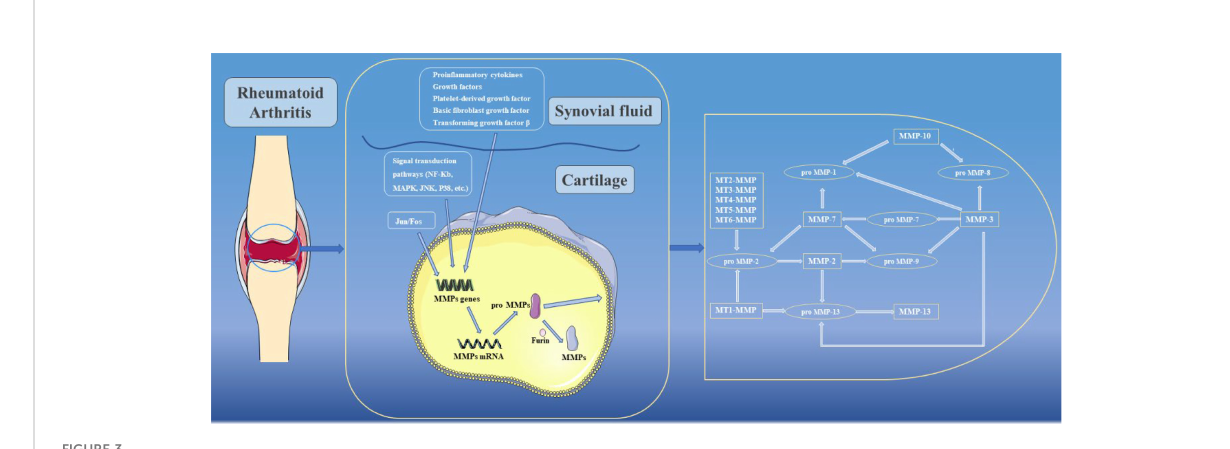
FIGURE 3 Regulation of MMPs and enzyme activation relationships between